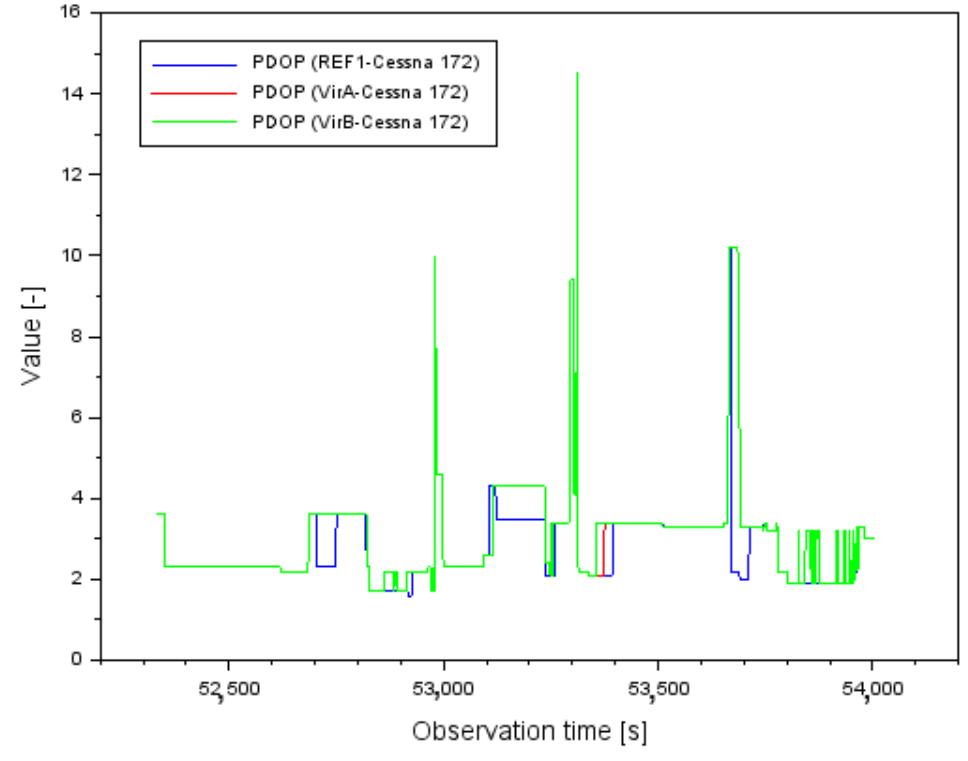
Figure 2. Mean 3D errors for each baseline.